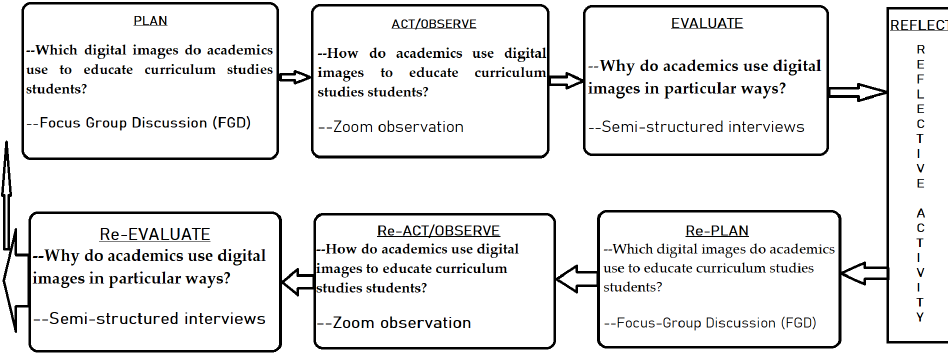
Figure 2. Two phases of participatory action research (PAR).